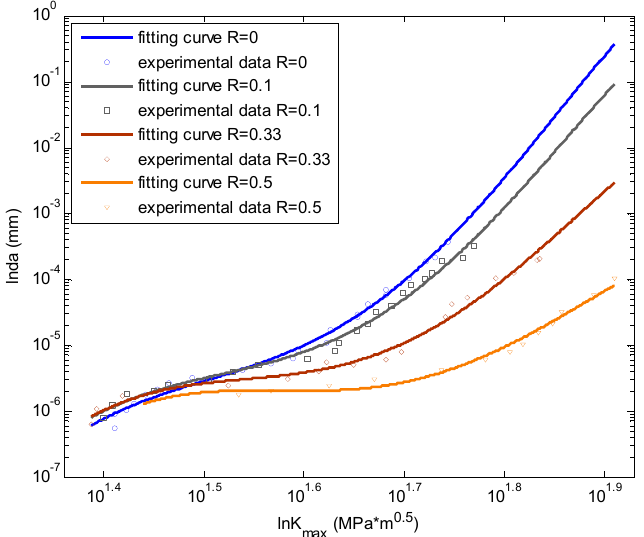
Figure 11. The fitting by ANN vs. the testing data for Al2024-T315.